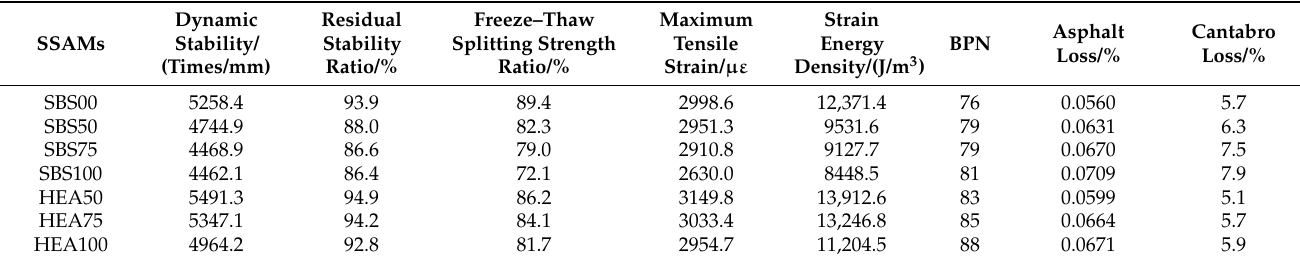
Table 8. Raw data for eight indicators.